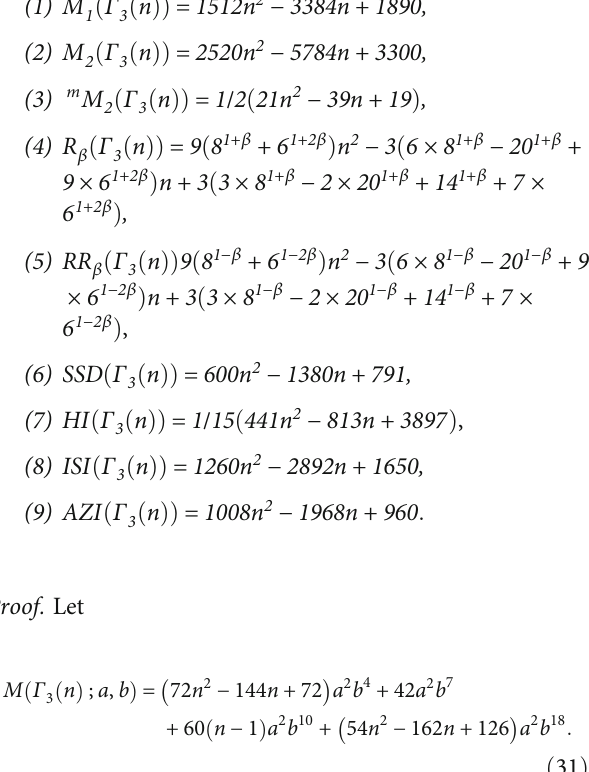
n Þ , Γ n Þ , and Γ n Þ using 2D graphs of ABC 1 ð 2 ð 3 ð